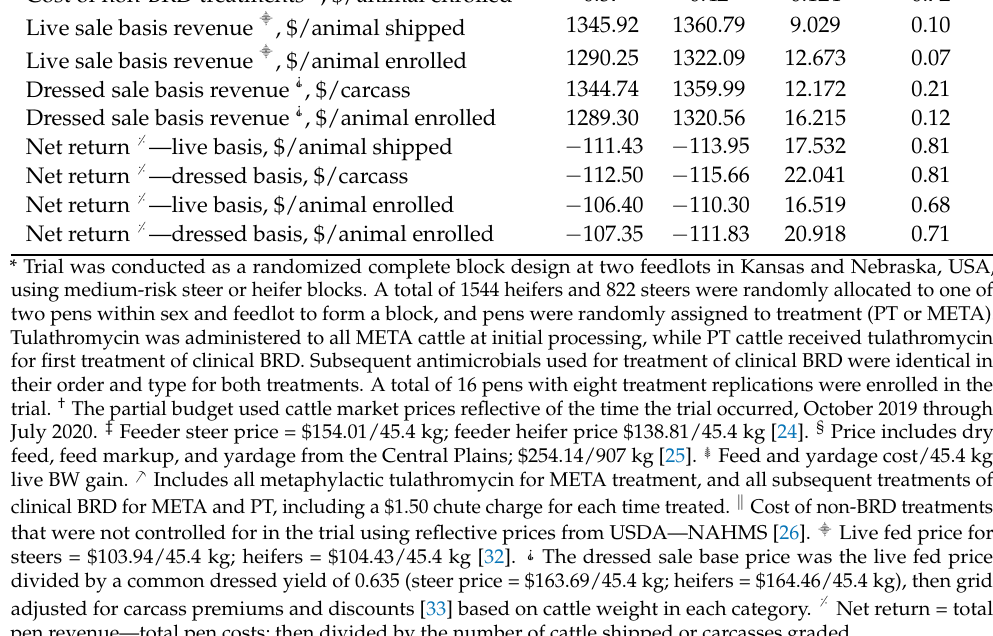
Table 3. Model adjusted means and standard errors of the mean (SEM) for feedlot performance outcomes of steers and heifers at medium risk for bovine respiratory disease (BRD) that received metaphylaxis (META) or a pull-and-treat (PT) health program for BRD* .